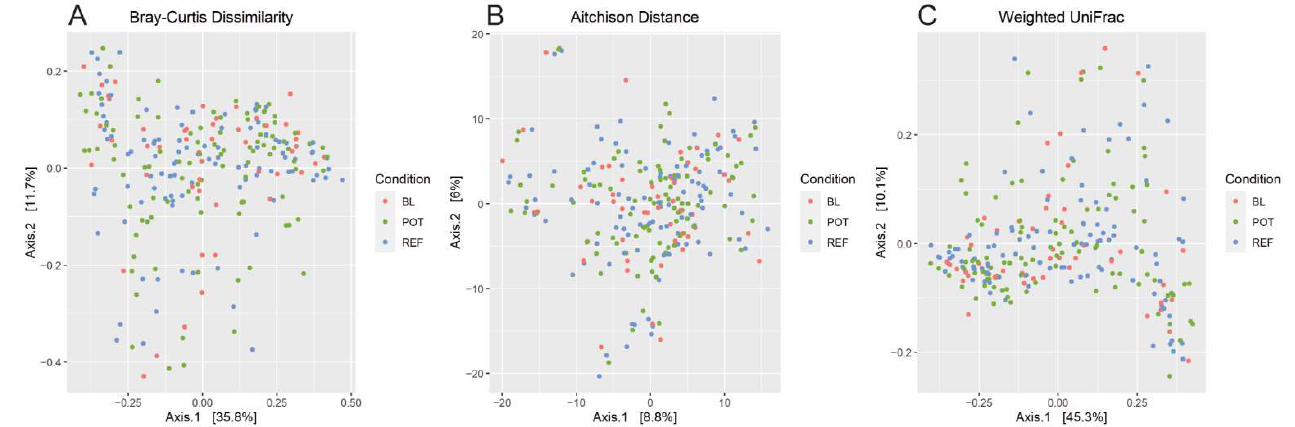
Figure 3. Beta diversity analysis. The microbiotas of all participants were assessed for between sample microbial diversity at baseline and during each diet condition. Bray–Curtis dissimilarity, Aitchison distance, and Weighted-UniFrac were used to assess the differences between the communities via principal coordinate analysis. Statistical comparison was made via PERMANOVA analysis. p < 0.05 was considered significant.